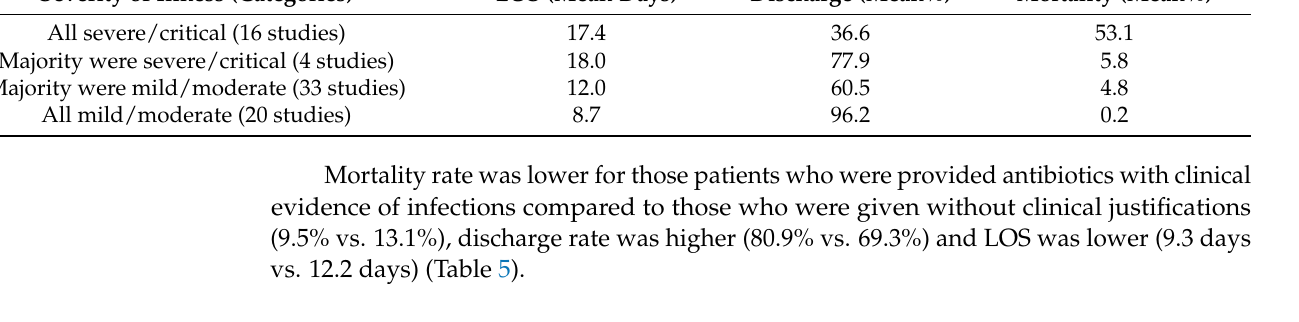
Table 5. Antibiotic prescribing justifications and health outcomes.